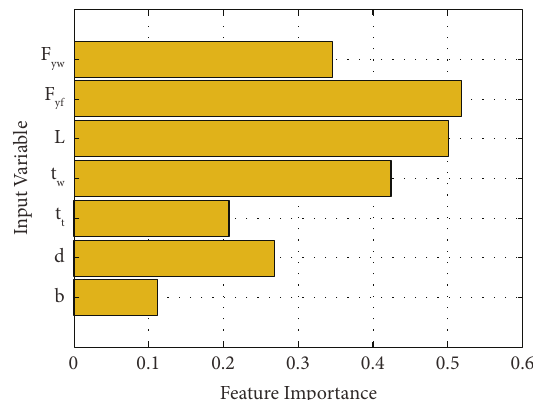
Figure 10: Feature importance analysis of 7 variables used in this